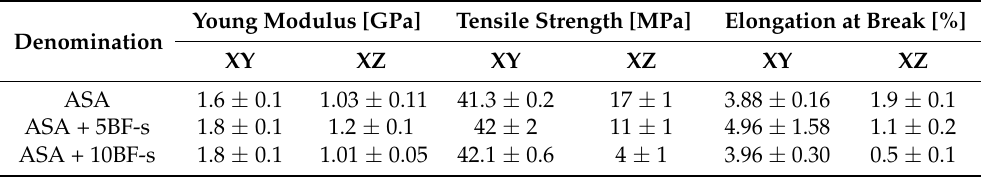
Table 3. Mechanical properties of specimen printed in XY and XZ orientation by FFF of ASA, ASA + 5BF-s and ASA +